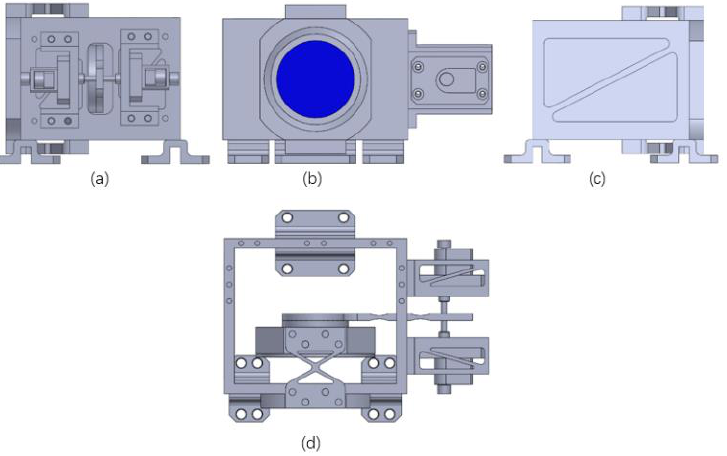
Figure 1. 3D model of the assembly of the swing micro-mirror structure: ( a ) right view; ( b ) main view; ( c ) left view; ( d ) upper view.